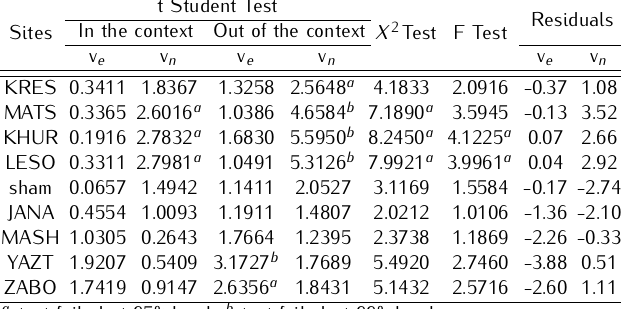
Table 2. Tests results (block B1). The results of the statistical tests for the GPS site data components. The sites passed from all the tests are the accepted data. The tests have been performed in two confidence levels (95% and 99%). t Student Test Residuals In the context Out of the Sites X 2 Test F Test